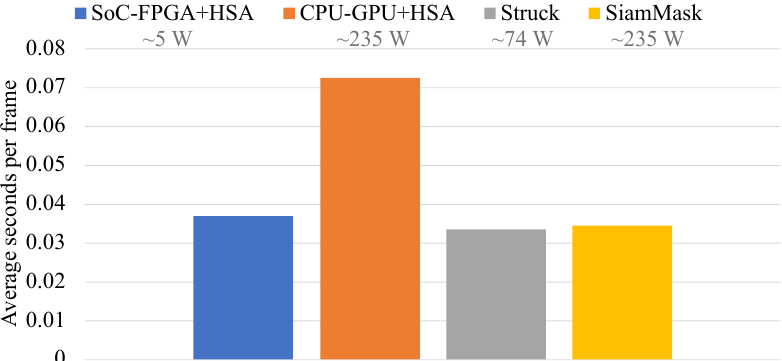
Figure 11. Comparison of the SoC-FPGA system against state-of-the-art trackers in terms of time- costs. The results of the CPU-GPU system are shown for contrast. Labels provide information about the estimated power consumption of the hardware that is typically used in each proposal. Note that the SoC-FPGA system is the only proposal that meets low-energy requirements.